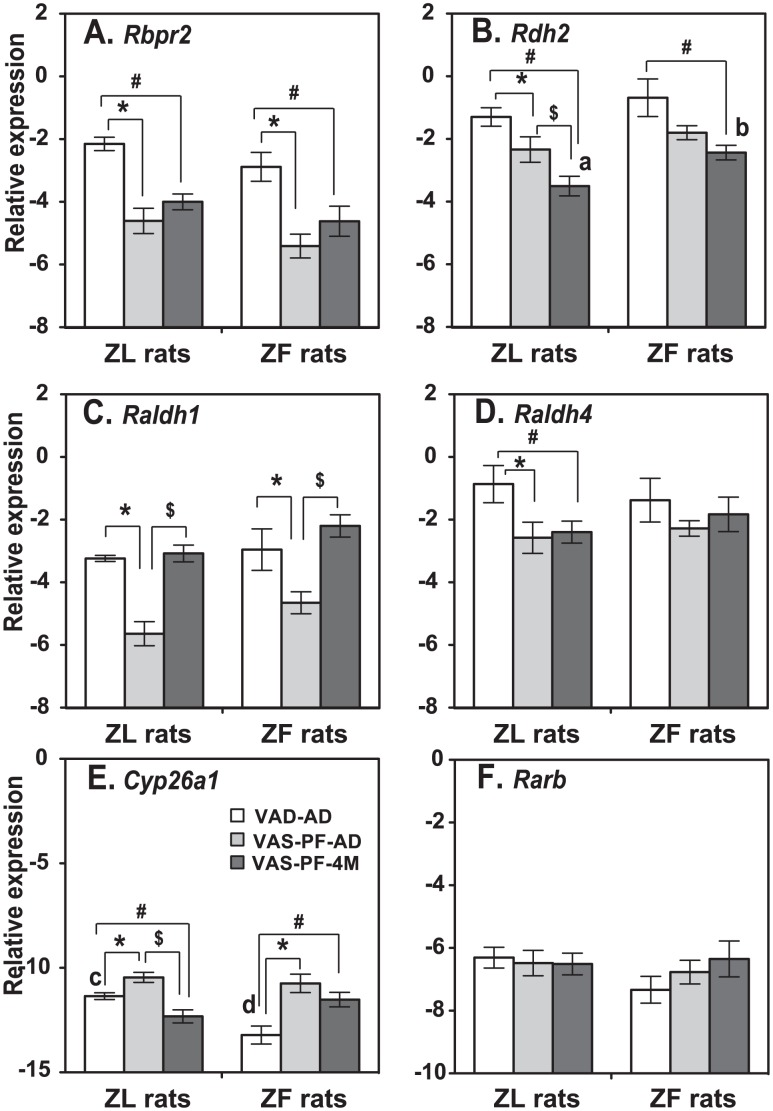
Differential expression levels of vitamin A metabolic genes in ZL and ZF primary hepatocytes.The expression levels of Rbpr2 (A), Rdh2 (B), Raldh1 (C), Raldh4 (D), Cyp26a1 (E), and Rarb (F) were determined by real-time PCR in the cultured primary hepatocytes receiving no treatment. The data were expressed as −ΔCt (36B4 - gene of interest). All p<0.05; *, #, and $ for comparing the effects of dietary manipulation variables on gene transcript levels using two-way ANOVA with Bonferroni's post-hoc test; a>b, and c>d, using Student's t-test to compare ZL with ZF with the corresponding dietary manipulation.